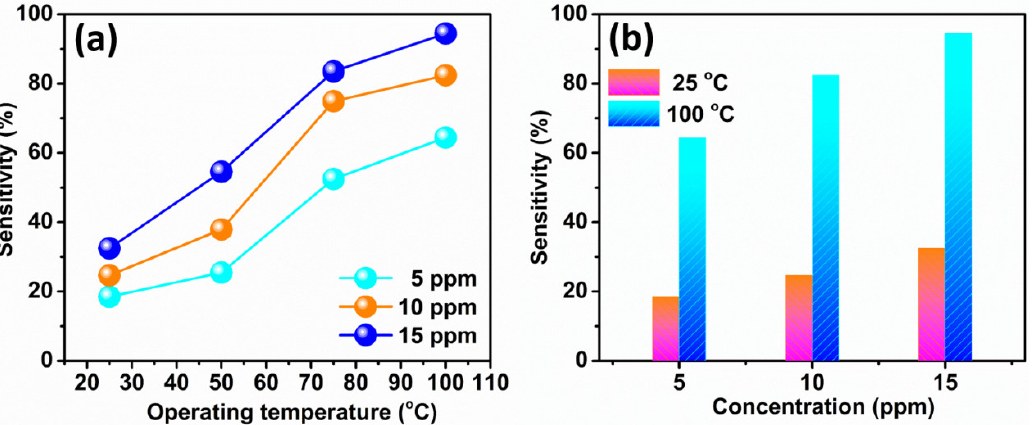
Figure 5. ( a ) Acetone sensitivity vs. temperature plots and ( b ) acetone sensitivity vs. concentration plots of the WS 2 nanorod